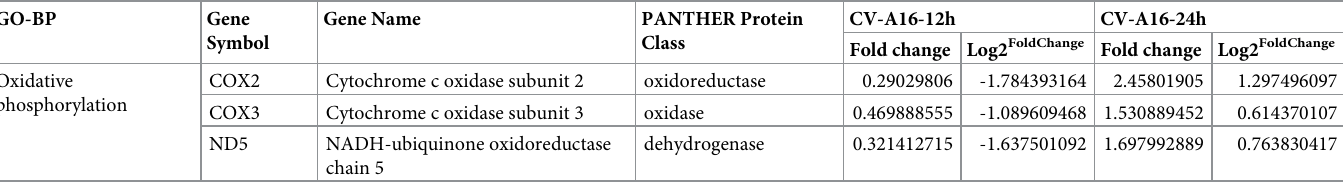
Table 2. Oxidative phosphorylation-associated differentially expressed genes in GO-BP analysis. GO-BP